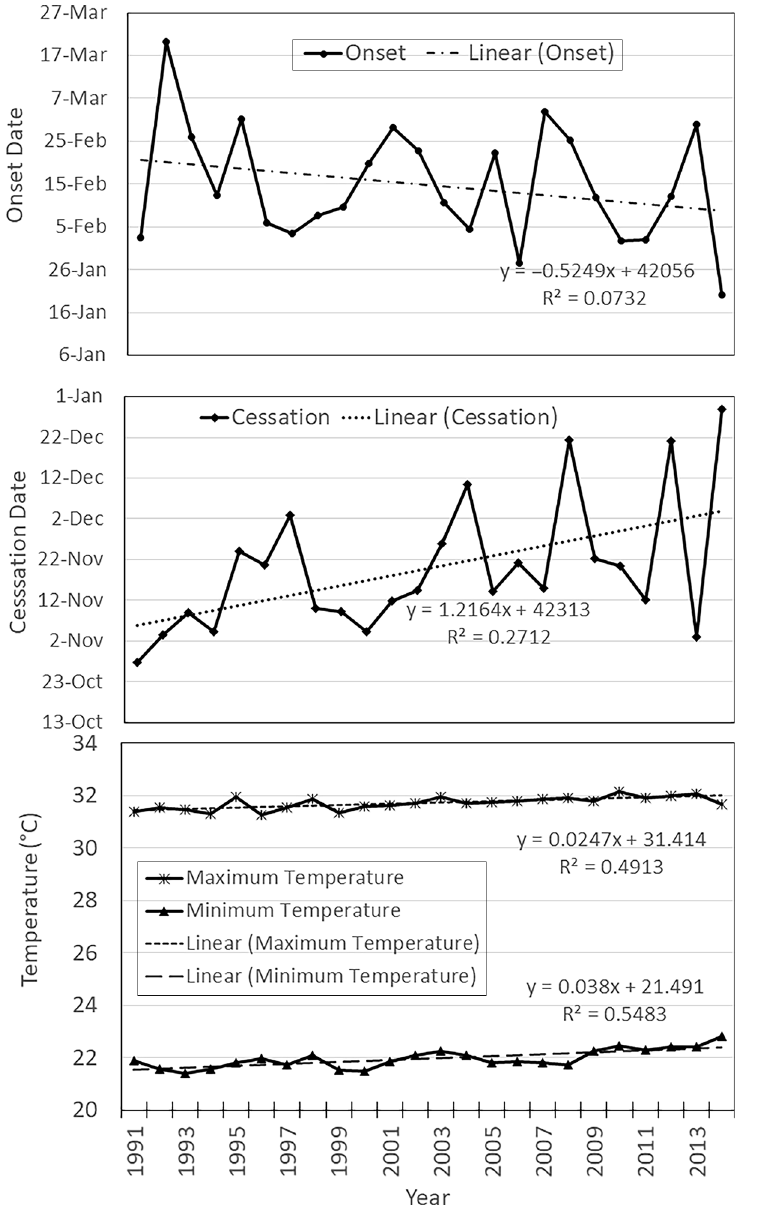
Figure 5. Trend of